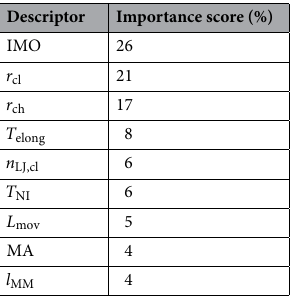
Table 4. Importance score of descriptors for stress–strain curves derived from the decision tree (descending